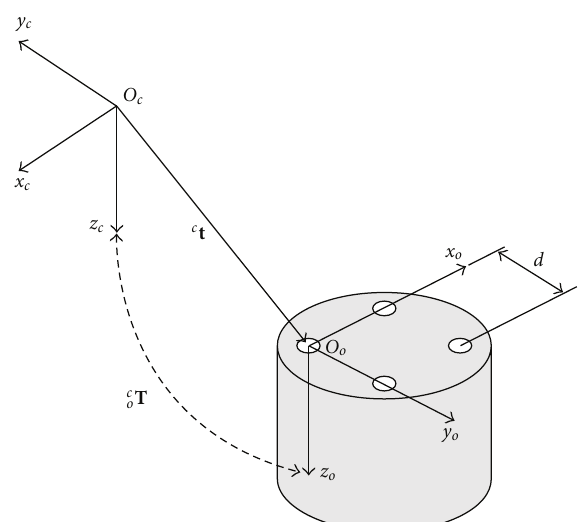
Figure 2: Object frame attached to the visual pattern and camera reference